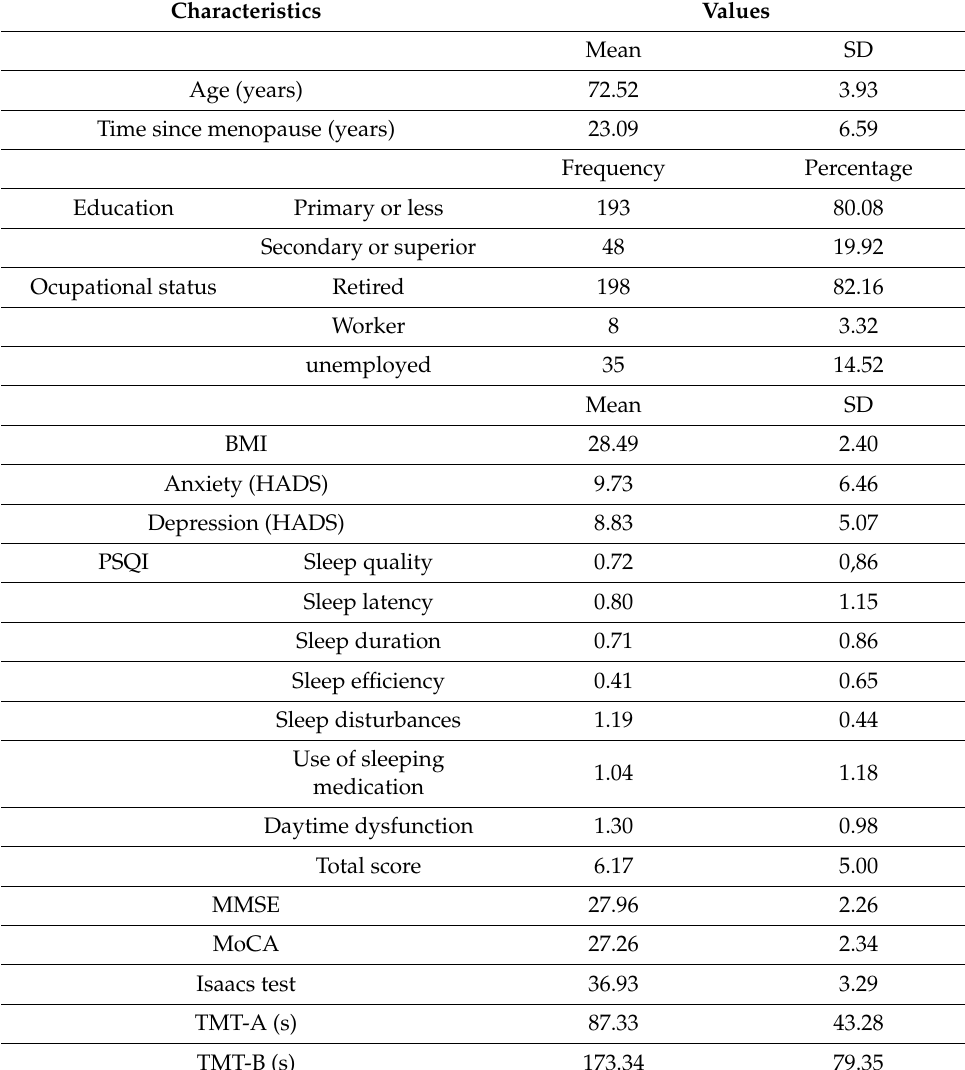
Table 1. Descriptive data of the participants ( n =